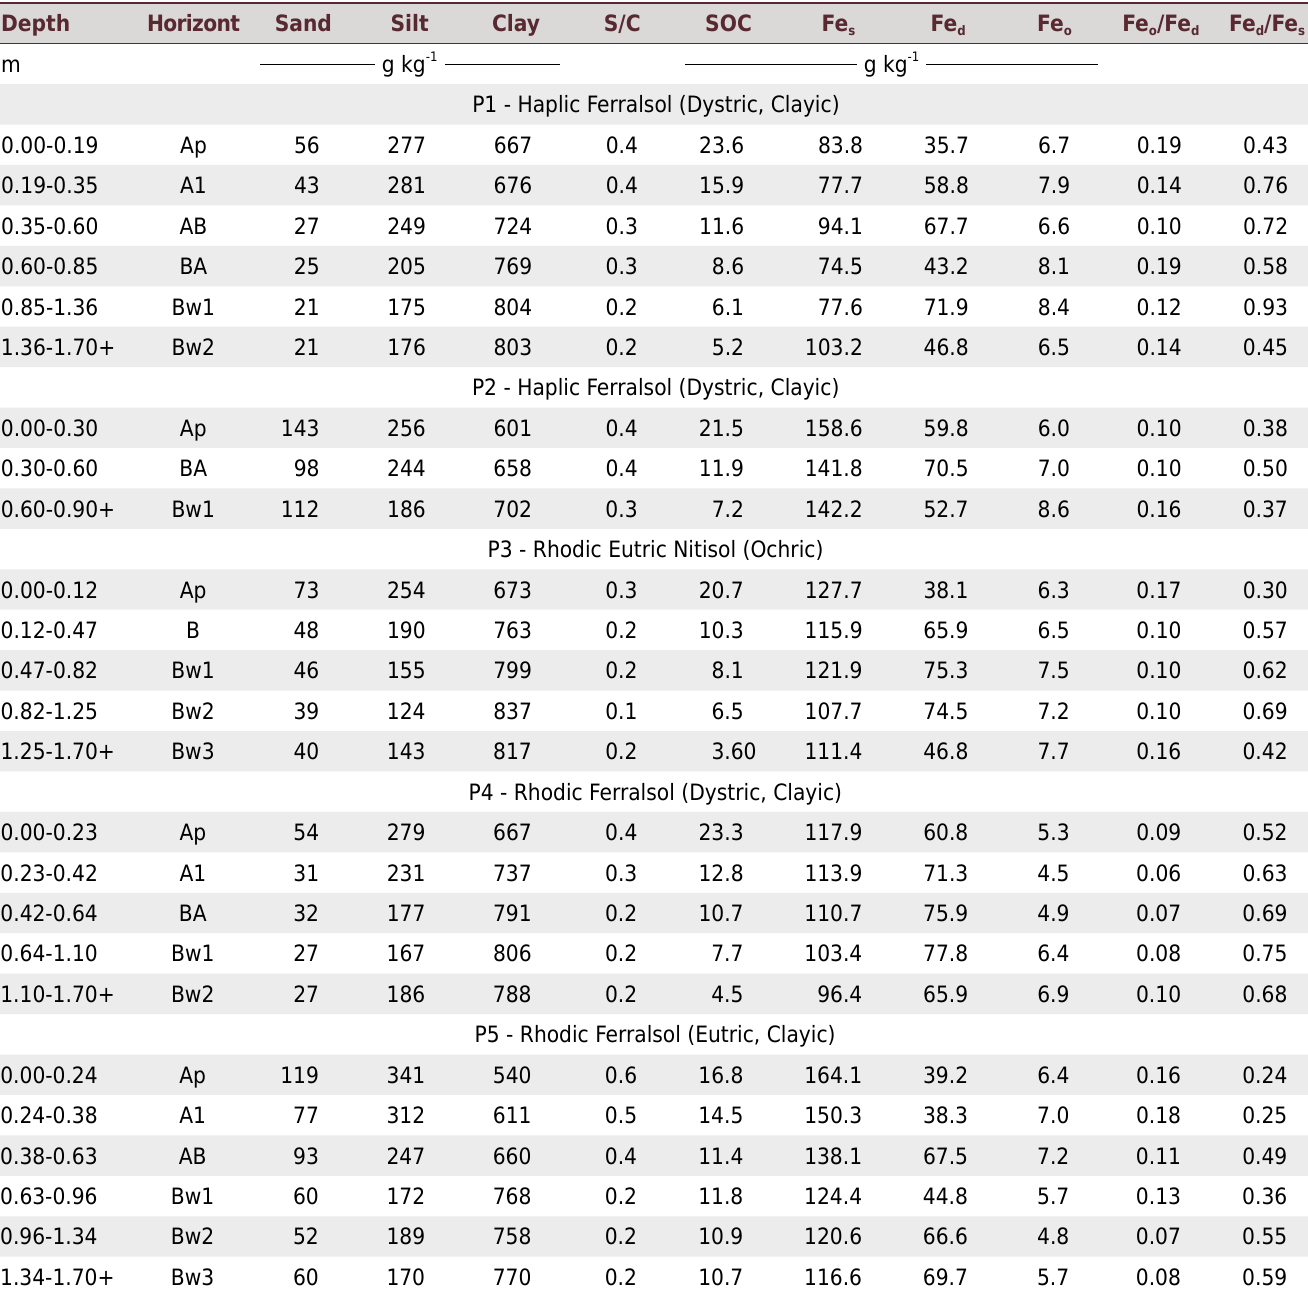
Table 1. Soil morphological, physical and chemical properties of the five studied profiles Depth Horizont